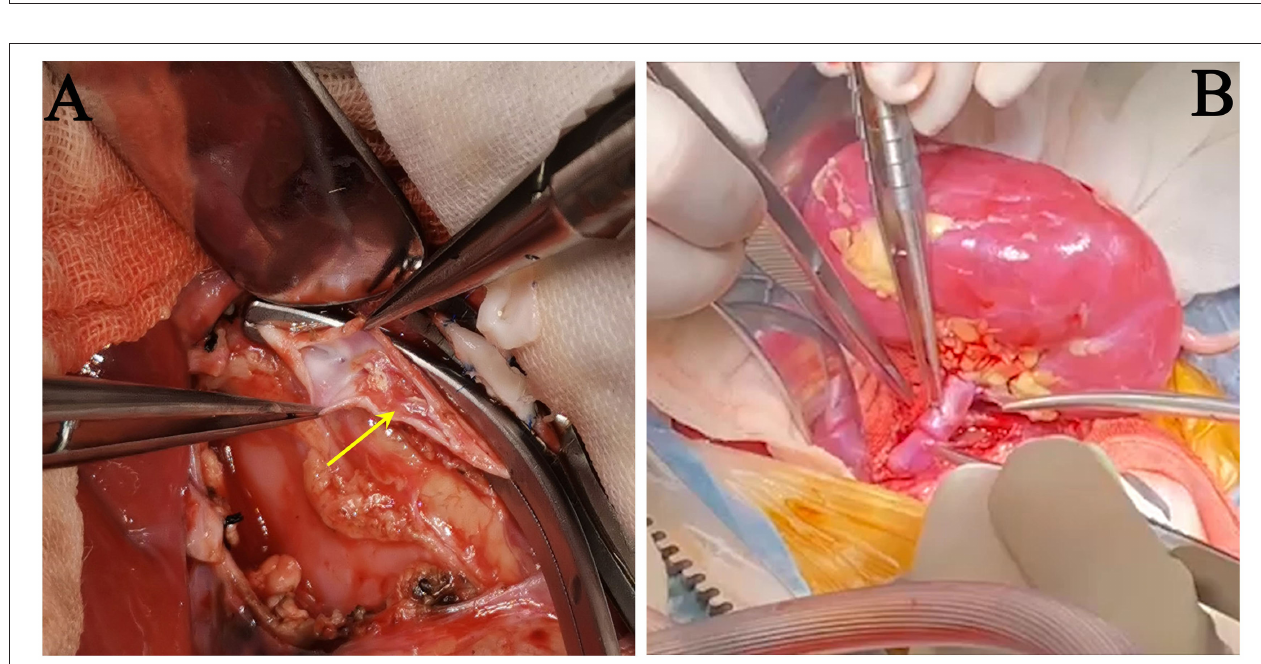
FIGURE 2 | Images during surgery. (A) Removal of the thrombo-embolus inside the recipient’s inferior vena cava, caused by catheterization from the right femoral vein (yellow arrow). (B) The renal artery and vein were end-to-side anastomosed onto the recipient’s abdominal aorta and inferior vena cava. The kidney graft was perfectly perfused after the Satinsky vascular clamps were